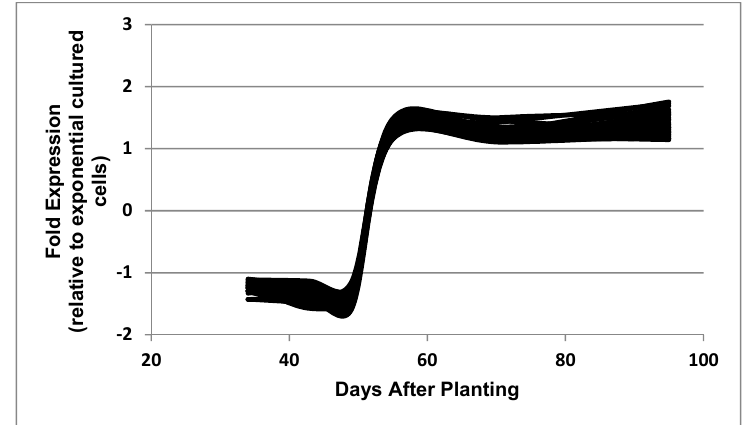
Figure 8. Expressed genes representing the post-symbiotic category. The 33 genes shown in the figure are: bll3172, bll4771, bll6387, bll6597, bll8078, blr0490, blr0998, blr2666, blr2834, blr2882, blr2923, blr3110, blr3499, blr3603, blr3634, blr3898, blr4361, blr5112, blr7482, blr7579, bsr1885, bll0052, bll0242, bll0244, bll0493, bll1533, bll2075, bll2188, bll4292, bll6051, blr4337, blr7208, and blr7482. Table 2. Examples of B. diazoefficiens genes expressed during the symbiosis of soybean root nodules following the pattern displayed in Figure 1B.